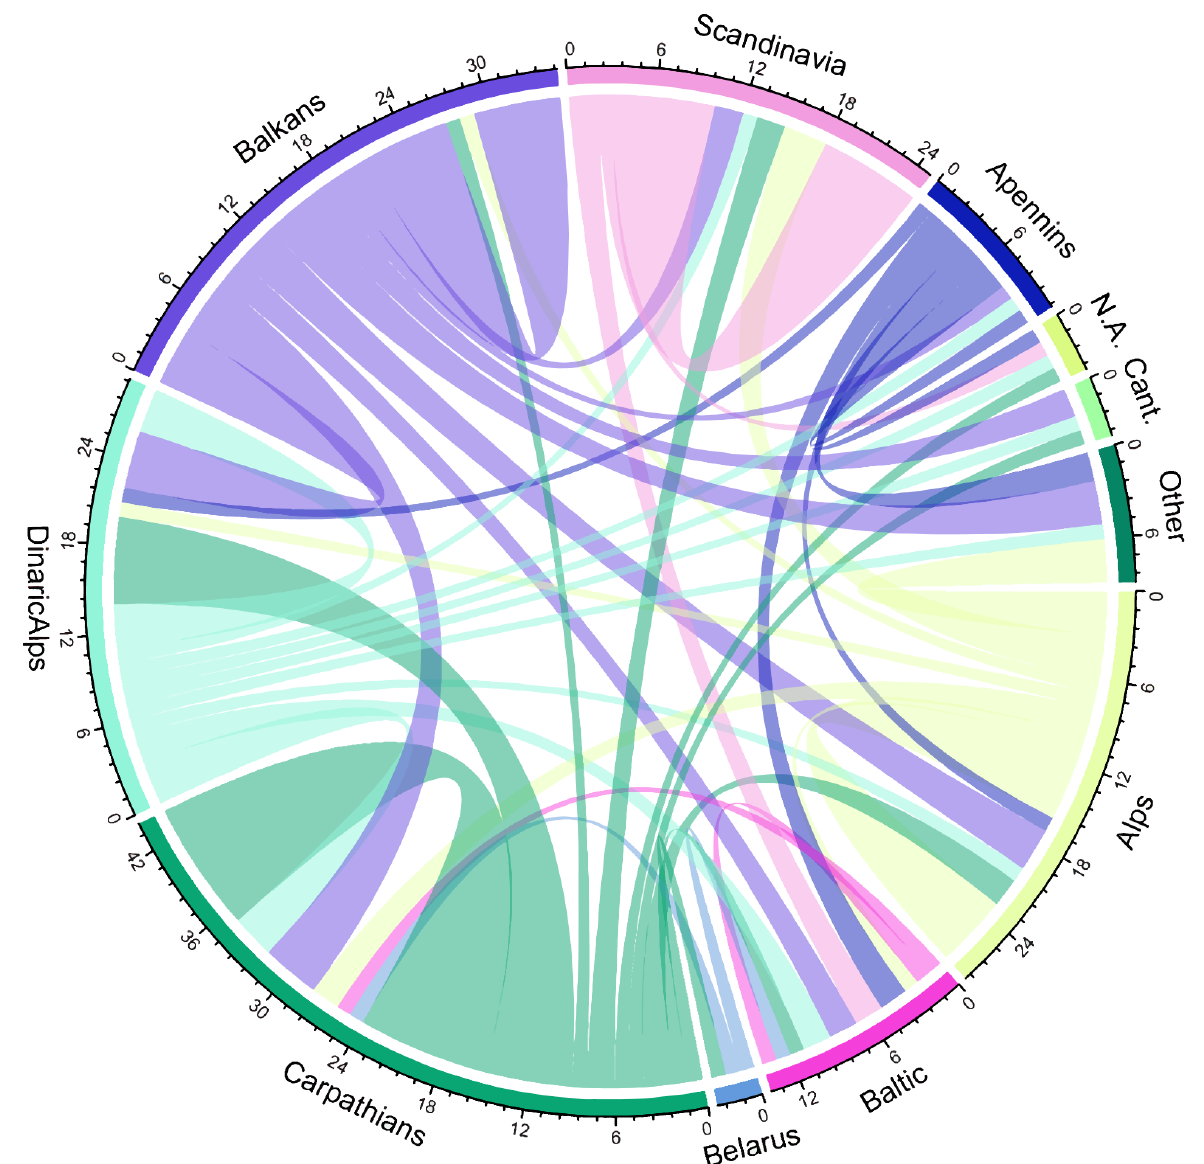
Figure A9. International sharing of information (N.A. = North America, Cant. = Cantabrians, Other = Alps-Dinaric-Pindos, North Africa, Middle East, Western Europe, Iberic Peninsula, Vosges- Palatinian, Bohemia-Bavara).